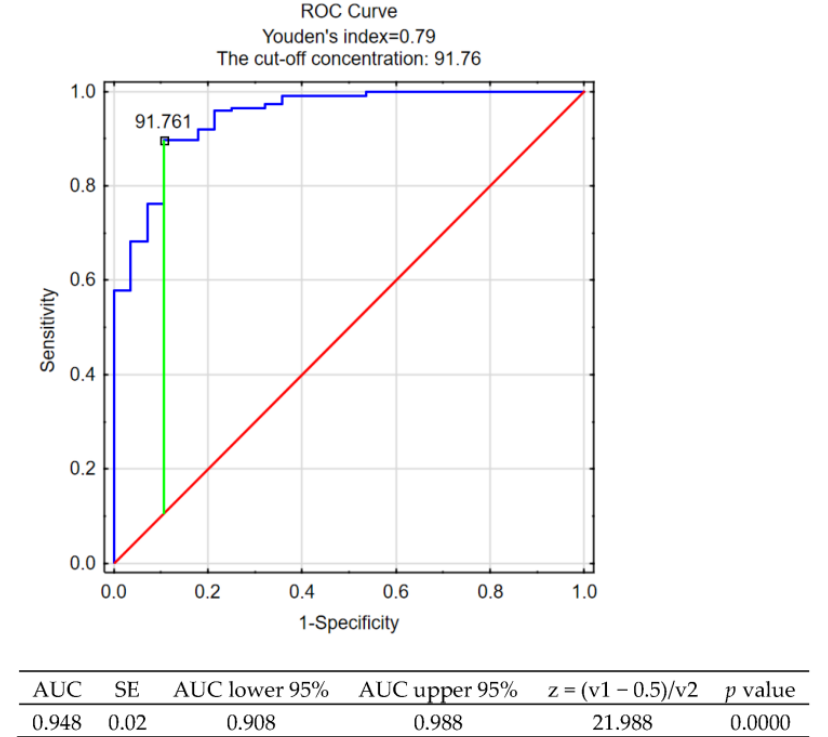
Figure 1. ROC curve of AOPP concentration for distinguishing patients with RRMS from the control group (x = 0.1071; y = 0.8969).